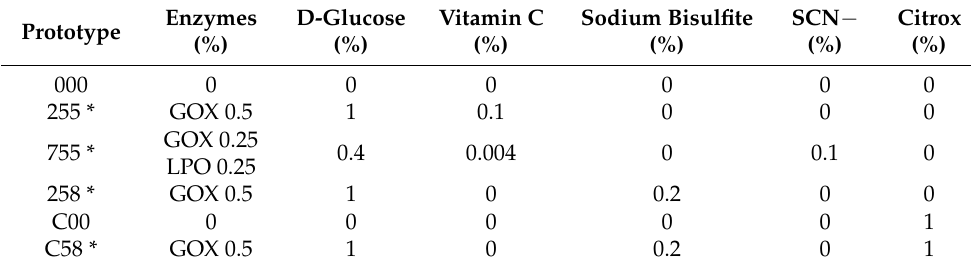
Table 1. Composition of six prototype toothpastes used in the in vitro preliminary testing. The prototypes in bold (258, C58) were applied as enzymatic-containing toothpastes in the randomized clinical trial.